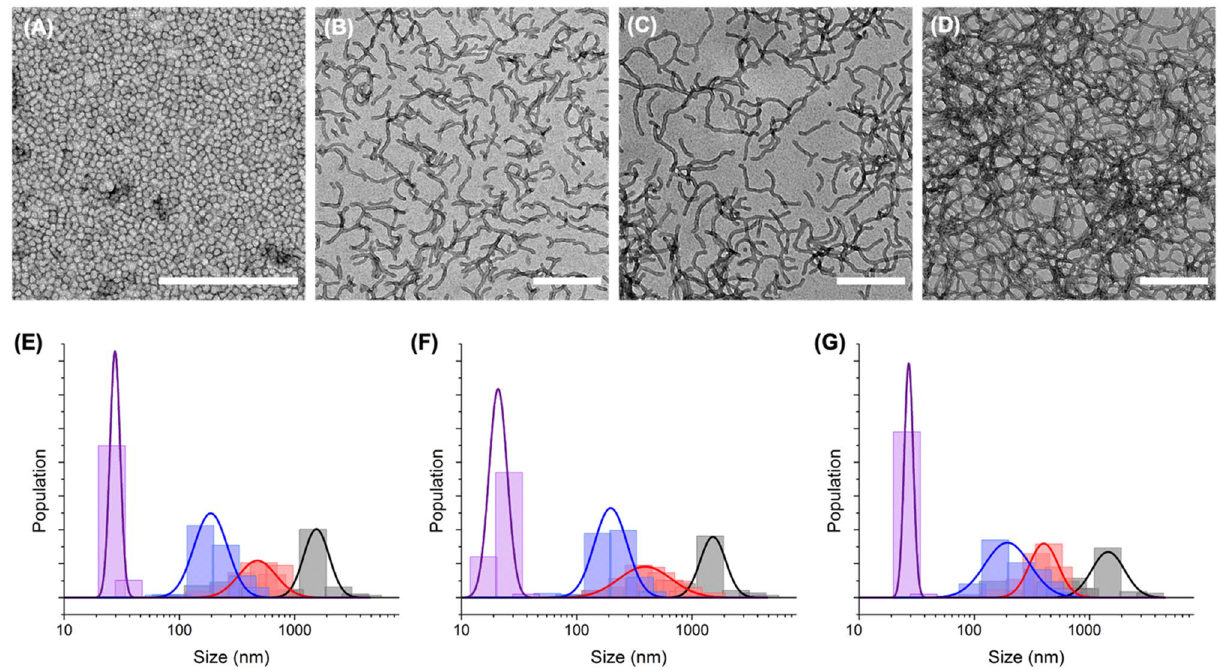
Figure 2. TEM images of colloids ( A ) SM NCC , ( B ) SWM NCC , ( C ) MWM NCC , ( D ) LWM NCC . Scale bars are 500 nm. Size distribution of the colloids prepared with increasing crosslinking density, ( E ) uncrosslinked colloids (NCC), ( F ) low core crosslinked colloids (LCC), and ( G ) high core crosslinked colloids (HCC) for (purple) spherical colloids (SM), (blue) short worm-like colloids (SWM), (red) medium worm-like colloids (MWM), and (black) long worm-like colloids. The bars in the histograms represent the measurement of the colloid population obtained (See Supporting Information), and the solid lines represent fits of the population measured to a log- normal distribution.